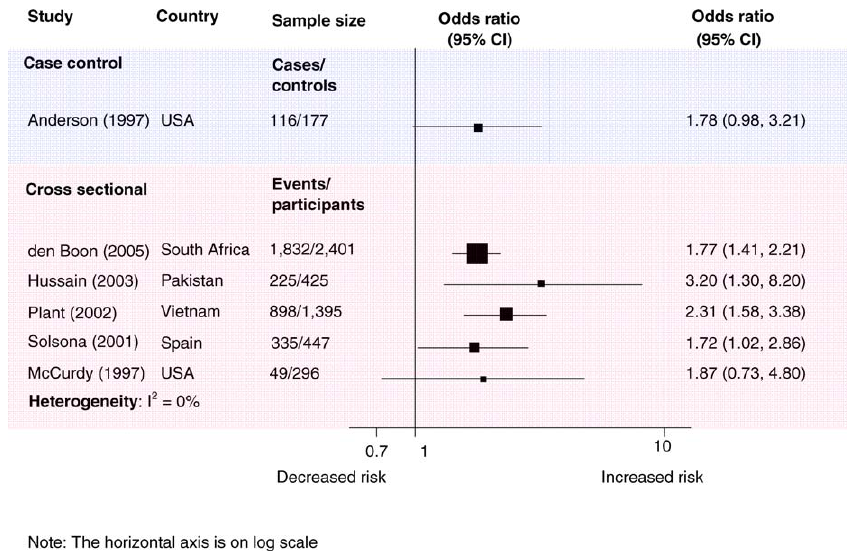
Figure 2. Risk of Latent TB Infection for Smoking Compared with Nonsmoking